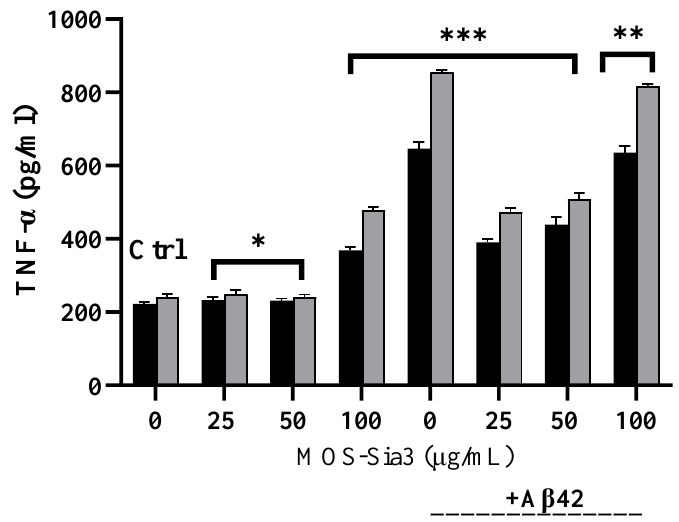
Figure 8. Effects of MOS-Sia3 on cytokine secretion in BV-2 cells induced by A β 42. Captions: Black bar, 24 h of culture; gray bar: 48 h of culture. Data are shown as the mean ± SD of triplicates with good reproducibility. SD is represented as error bars. Statistically significant differences are indicated: ** for p ≤ 0.01, and *** for p ≤